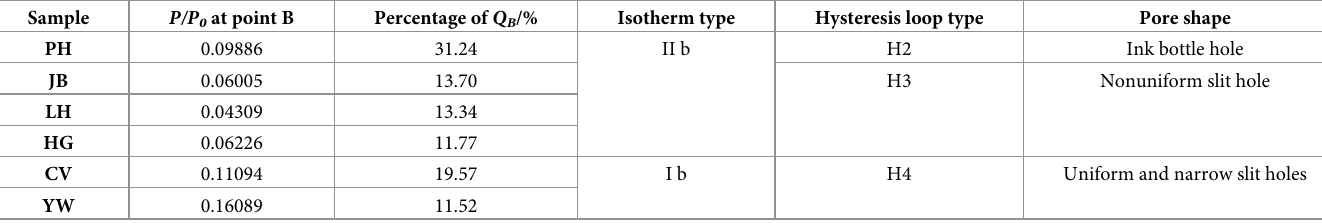
Table 2. N 2 adsorption/desorption isotherm analysis of coal samples with different coal ranks. Sample P/P 0 at point